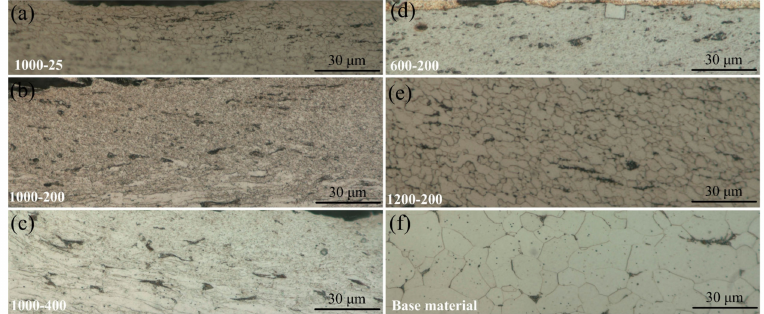
Figure 6. The variation of steel fine grain zone with different welding parameters. ( a ) 1000 rpm, 25 mm/min; ( b ) 1000 rpm, 200 mm/min; ( c ) 1000 rpm, 400 mm/min; ( d ) 600 rpm, 200 mm/min; ( e ) 1200 rpm, 200 mm/min; and ( f ) steel base